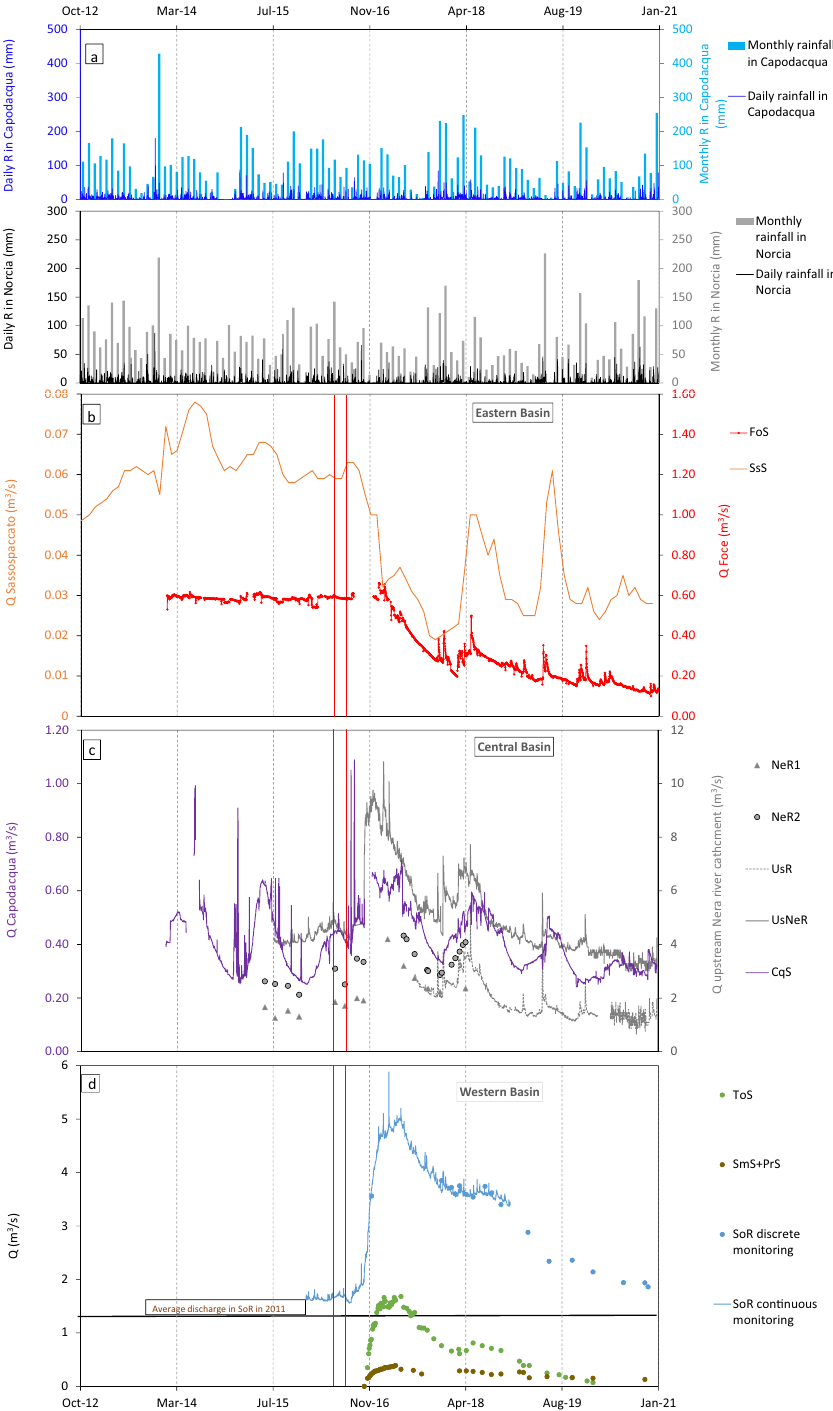
Figure 2. Daily rainfall in representative gauges and discharge of monitoring points. ( a ) Daily Rainfall (R) in Norcia and Capodacqua, respectively representative for systems located on the western and on the eastern slope. ( b ) Mean discharge (Q) of the main springs located in the Eastern Basin (VBFS footwall) at a daily (FoS) and monthly (SsS) scale. ( c ) Discharge (Q) of stream and rivers of the Central Basin (hanging wall of both VBFS and of its antithetic system). CqS is located on the Eastern slope while other measures (NeR1, NeR2, UsR, UsNeR) are taken on streams and rivers (streambed gaining springs) pertaining to the Upstream Nera River System, on the western slope. ( d ) Discharge (Q) of springs, streams and rivers of the Western Basin (hanging wall of VBFS and footwall of its antithetic). The red vertical bars indicate the main seismic shocks of August 24th 2016 (Mw = 6.0) and October 30th 2016 (Mw = 6.5). Location of the measures is reported in Fig.